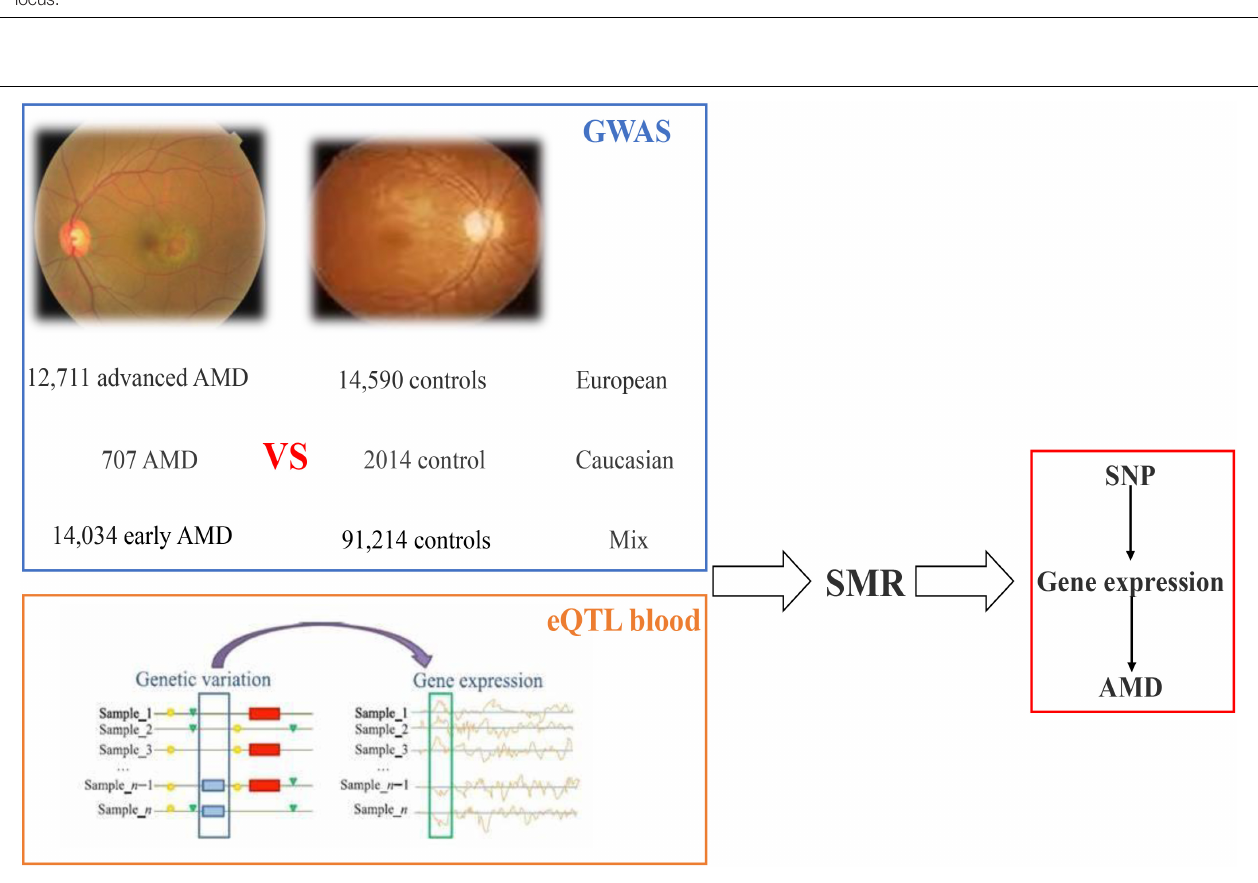
FIGURE 4 | Workflow of SMR on AMD based on GWAS and eQTL datasets. AMD, age-related macular degeneration; GWAS, genome-wide association studies; eQTL, expression quantitative trait locus; SMR, summary data-based Mendelian